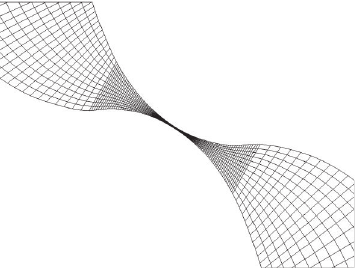
Figure 7: Mesh in rotor-rotor